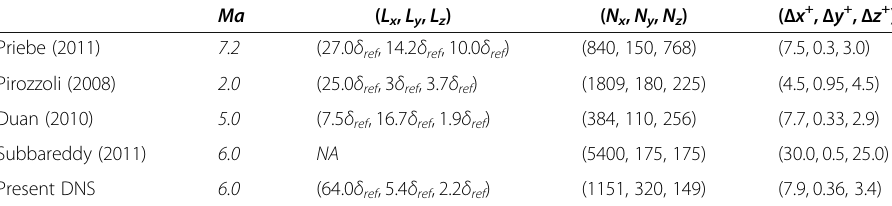
Table 2 Setup of the reference simulations